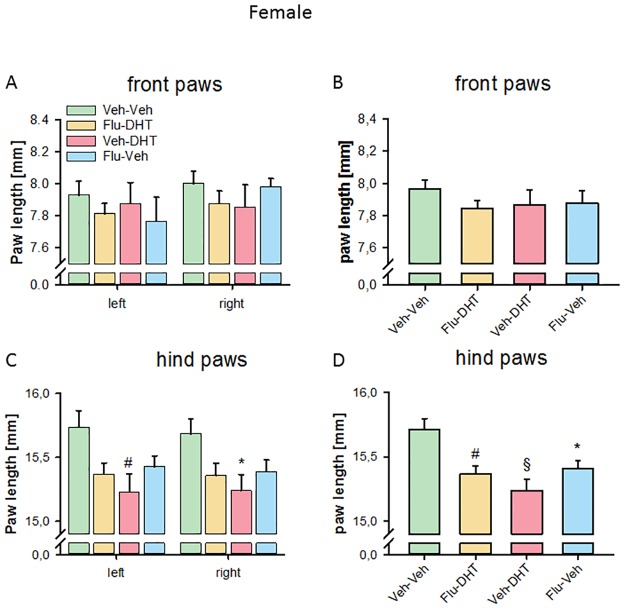
Shorter paws in females prenatally treated with Vehicle-Dihydrotestosterone.(A) Paw length of the left and right front paw. (B) Paw length of pooled (left + right) front paws. (C) Paw length of the left and right hind paw. (D) Paw length of pooled (left + right) hind paws. Data represented as mean ± Standard error of the mean (SEM). * p<0.05, # p<0.01 and § p<0.001 compared to control. Veh—Vehicle; Flu—Flutamide; DHT—Dihydrotestosterone.